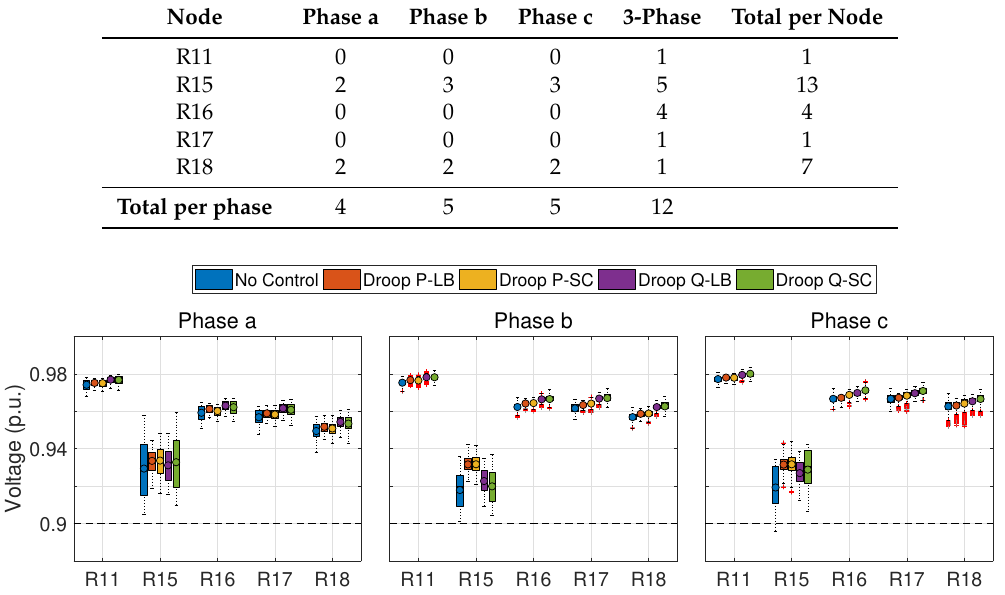
Figure 13. Voltage levels for Scenarios VII, VIII, IX, X, and